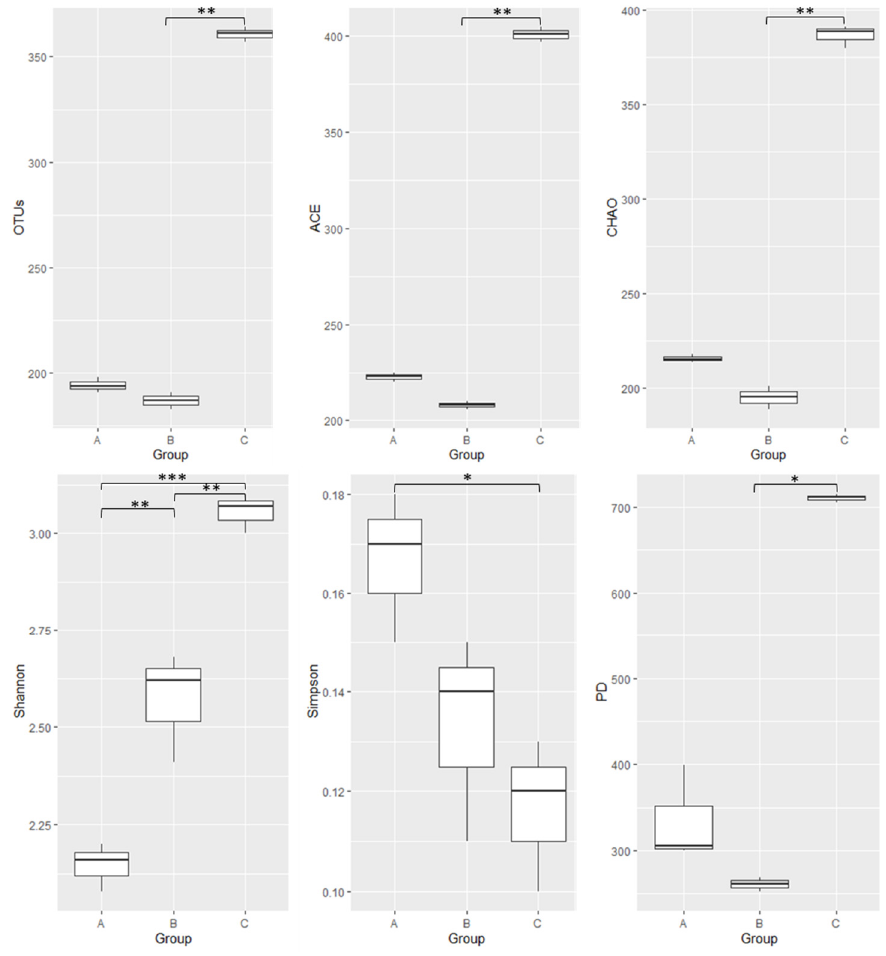
Figure 1. The average OTUs and alpha diversity indices of gut microbiota in larval (A), pupal (B), and adult (C) honeybees, Apis cerana . The alpha diversity indices include species richness (ACE, Chao, Jackknife), species evenness (Shannon, Simpson), and Phylogenetic diversity (PD). The significant difference between the two groups was marked as a significant difference (0.01 < p ≤ 0.05 is marked as *, 0.001 < p ≤ 0.01 is marked as **, and p ≤ 0.001 is marked as ***).